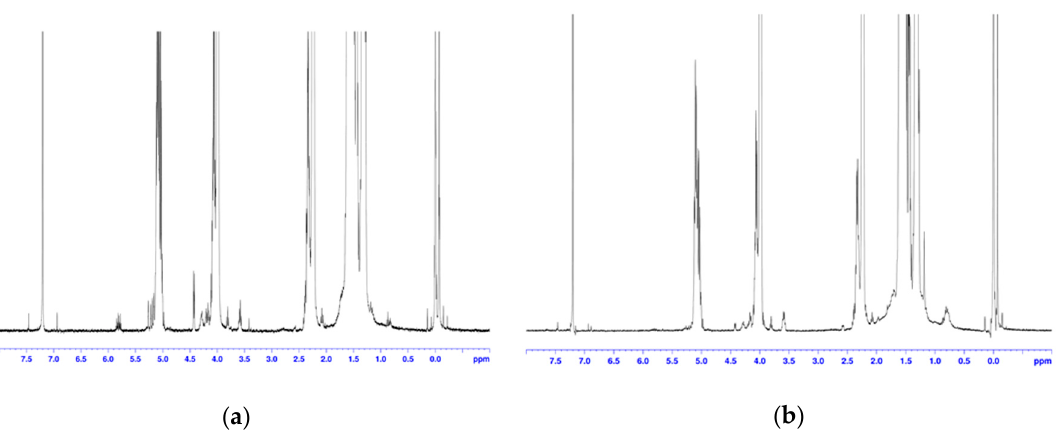
Figure 8. 1 H-NMR spectrum of triallyl isocyanurate (TAIC).